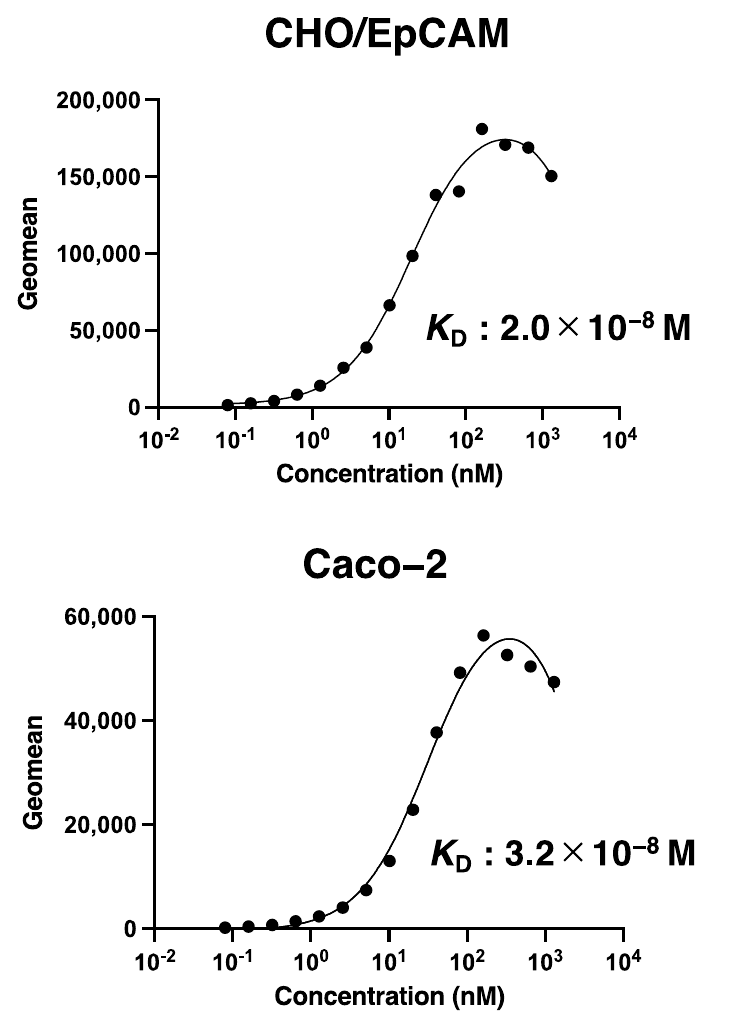
Figure 3. The determination of the binding affinity of recEpMab-37. CHO/EpCAM and Caco-2 cells were suspended in 100 µ L serially diluted recEpMab-37 (6 ng/mL to 100 µ g/mL). Then, cells were treated with Alexa Fluor 488-conjugated anti-mouse IgG. Fluorescence data were subsequently collected using a BD FACSLyric, following the calculation of the dissociation constant ( K D ) by GraphPad PRISM 8.